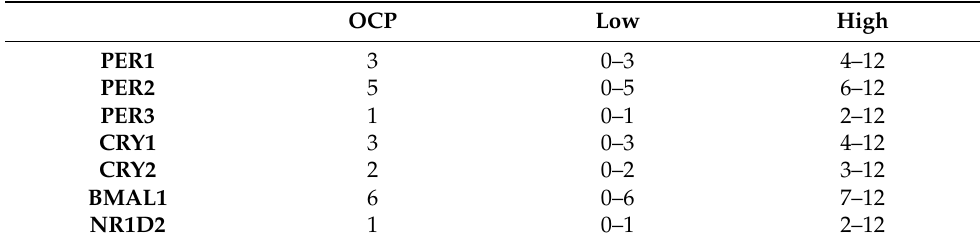
Table 2. OCP obtained for the core circadian clock proteins